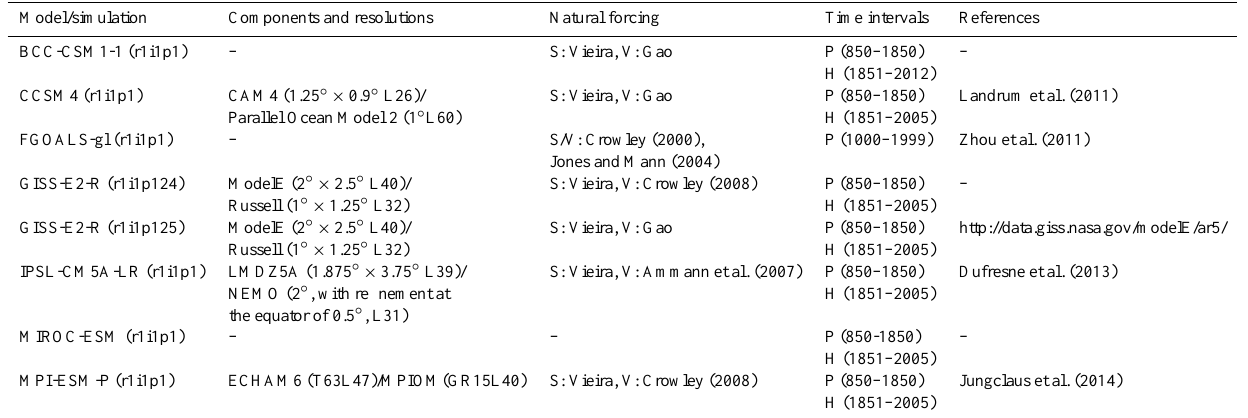
Table 1. Simulations considered in this study. Columns, from left: model and, in parentheses, simulation name; atmospheric and oceanic components (with resolution in parentheses); applied solar (S) and volcanic (V) external forcings; considered periods of the past1000 (P) and historical (H) integrations; references/sources of information. Names of models and simulations follow the acronyms adopted in the Coupled Model Intercomparison Project (CMIP) 5 repository. Full references for the applied solar and volcanic forcing are Vieira et al. (2011), Gao et al. (2008), Crowley (2000), Jones and Mann (2004) and Crowley et al. (2008). Model/simulation Components and resolutions Natural forcing Time